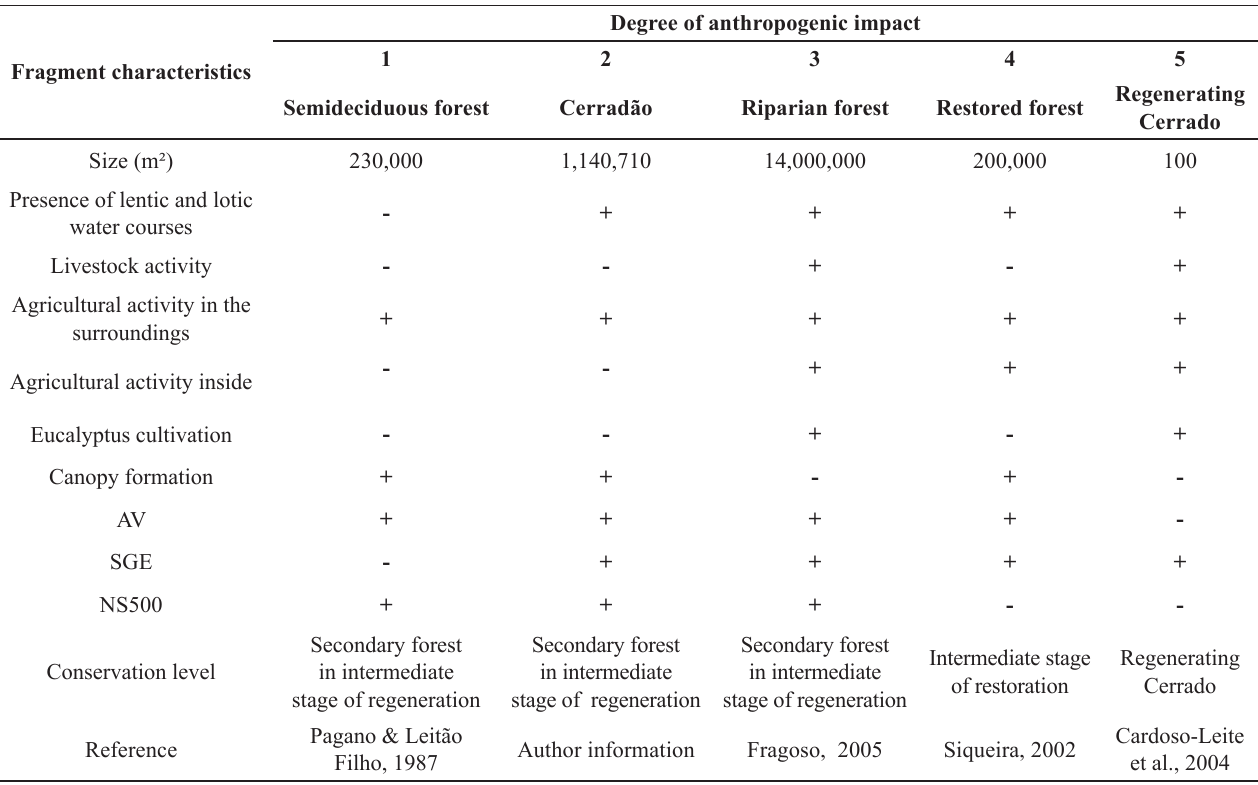
Table 1 . Characterization of different physiognomies in the east central of São Paulo according to the degree of anthropic impact. 1 –